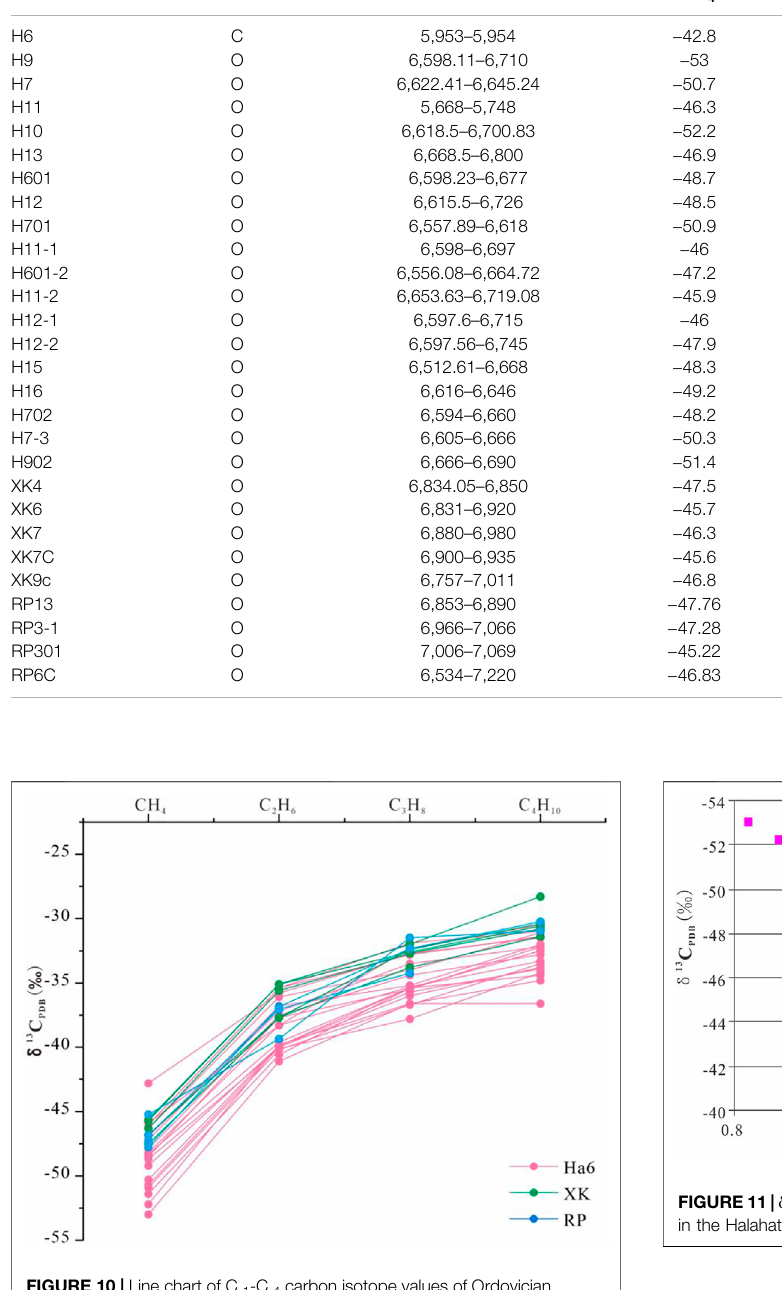
FIGURE 10 | Line chart of C 1 -C 4 carbon isotope values of Ordovician natural gas in the Halahatang Area.